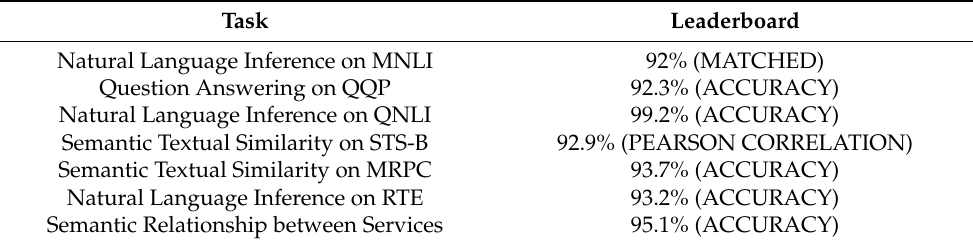
Table 2. Tasks and corresponding evaluation